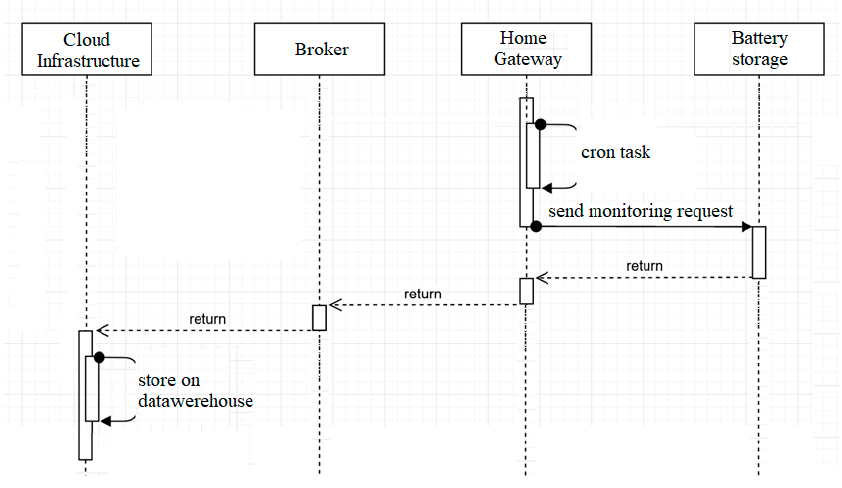
Figure 7. Data flow for sending monitoring requests to the battery storage operation.